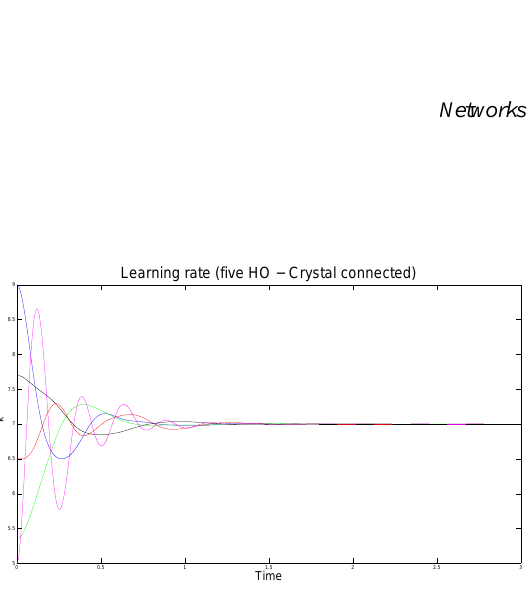
Fig. 3. Time evolution of the frequencies w k ( t ) for five Hopf oscillators with K 1 = 1, K 2 = 1 , K 3 = 5 , K 4 = 5, 2 4 w w w w K 1 1 ( 0 ) = 9, 2 ( 0 ) = 5 . 35, 3 ( 0 ) = 6 . 5, 4 ( 0 ) = 5, 5 = 3 w 5 ( 0 ) = 7 . 7 and with network topology “Crystal”. The con- sensual frequency, given by Eq.(10), is w c = 7.